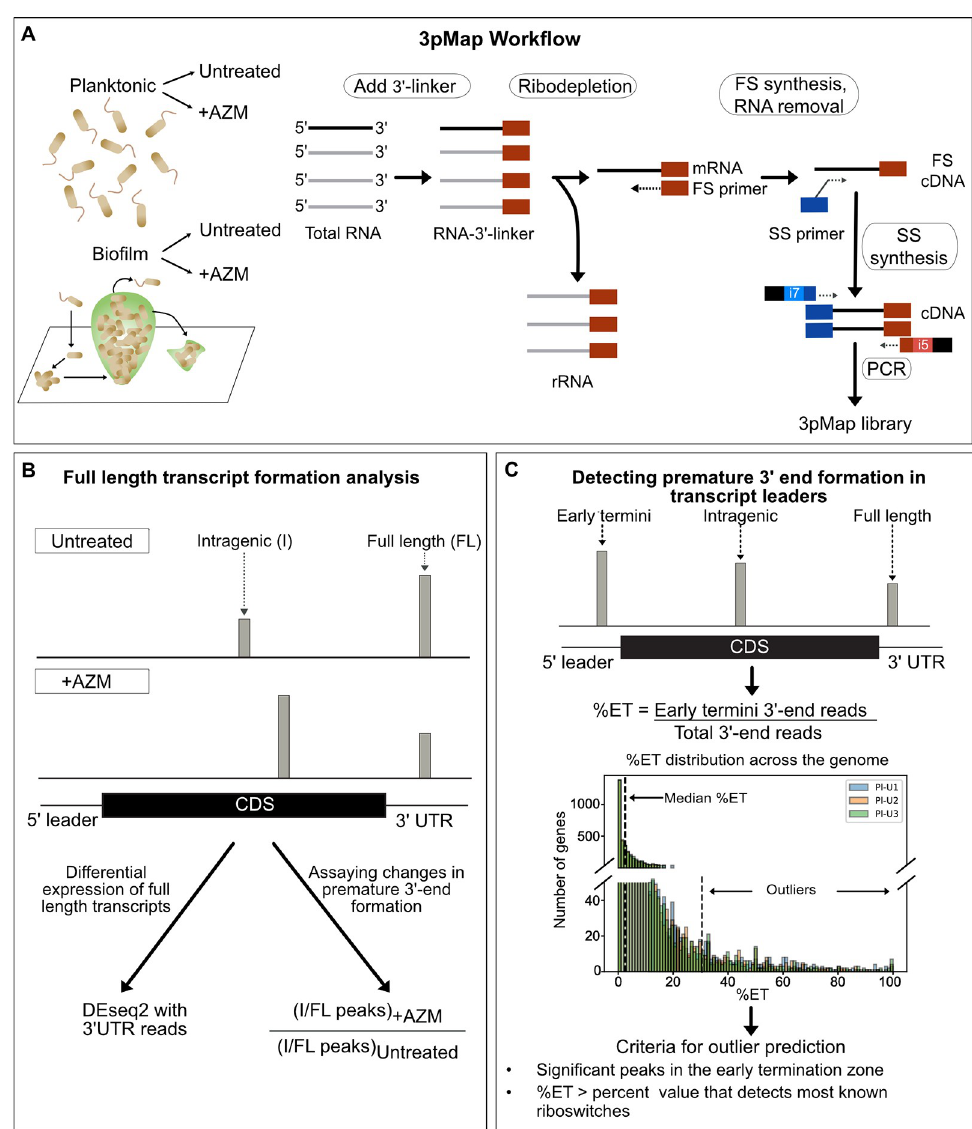
Fig 1. 3pMap workflow and data analysis. (A) 3pMap library synthesis. A 3’ adapter is ligated to total RNA, followed by rRNA depletion. The cDNA is generated by reverse transcription with oligos containing sequences complementary to the adapter (first strand, FS) and to random priming sites (second strand, SS). The cDNA libraries are PCR amplified to generate Illumina sequencing libraries. (B) Assaying changes in full length transcript synthesis. 3’ end reads and peaks were categorized as intragenic (I) and full length (FL) depending on their locations. Differential changes in gene expression were measured using DEseq2 of all 3’ end reads (see Methods). Relative changes in premature 3’ end formation were measured by comparing the I/FL peaks in AZM-treated vs. untreated samples. (C) Predicting RNA regulatory elements in transcript leader neighborhood. 3’ end reads are assigned to genes /operons and categorized as early termini (transcript leader + 40 nucleotides) (ET), intragenic (I), and 3’UTR or full length (FL) reads. Genes with significant 3’ end peaks in the ET zone and %ET > 30 are considered outlier